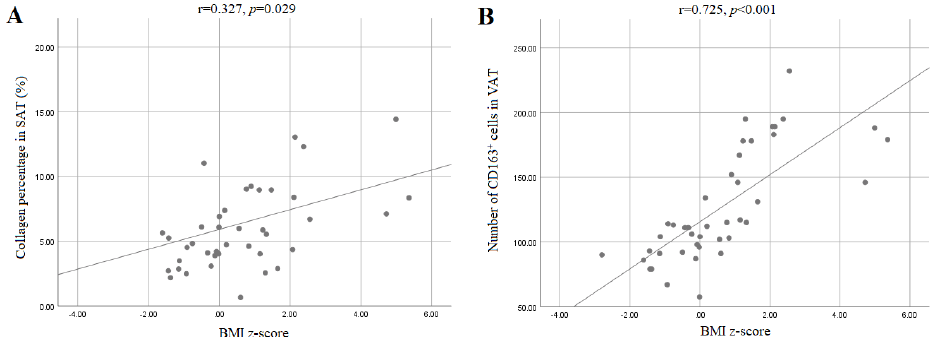
Figure 2. Pearson’s correlation between BMI z-score and ( A ) the collagen percentage in SAT and ( B ) the number of CD163 + cells in VAT. ( A ) The BMI z-score was positively associated with the collagen percentage in SAT ( r = 0.327, p = 0.029). ( B ) The BMI z-score was also positively associated with the number of CD163 + cells in VAT ( r = 0.725, p < 0.001). SAT—subcutaneous adipose tissue; VAT—visceral adipose tissue.